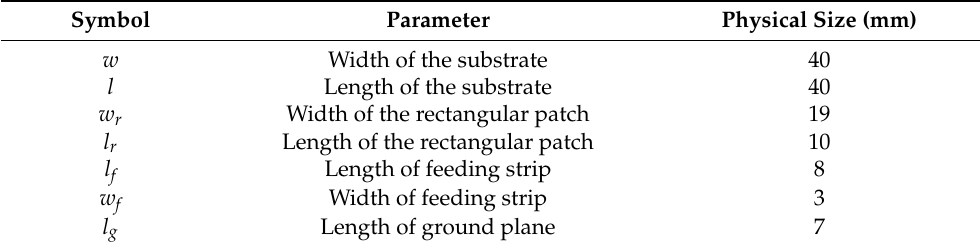
Figure 9. Simulated |S 11 | of the proposed antenna for various p . Table 1. Selected are the best values for parameters of the proposed